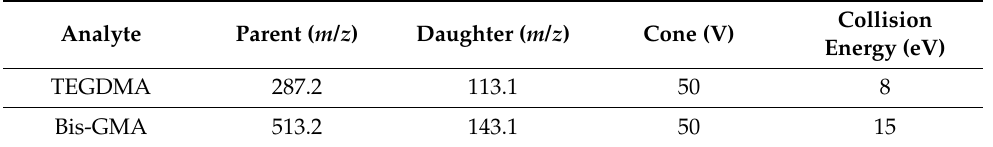
Table 2. MRM transition, cone potential, and collision energy for each